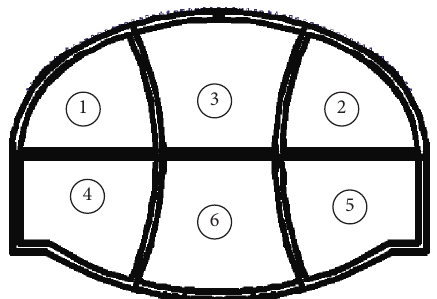
Figure 2: Construction process of double-side heading method.